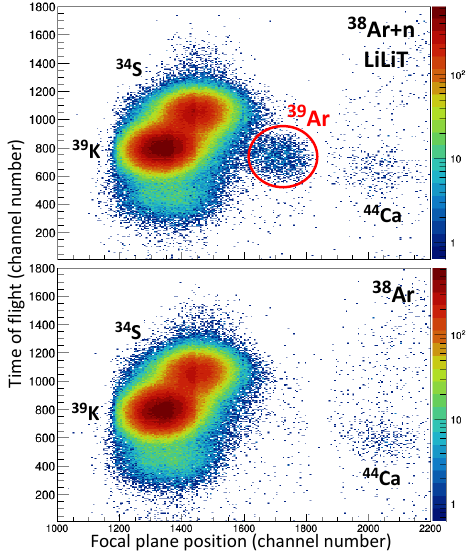
Figure 8. AMS identification spectrum of 39 Ar ions in the de- tector measured for the LiLiT irradiated 38 Ar gas (top) and for non-irradiated 38 Ar gas (bottom). The horizontal axis represents dispersion along the focal plane and the vertical axis the time-of-